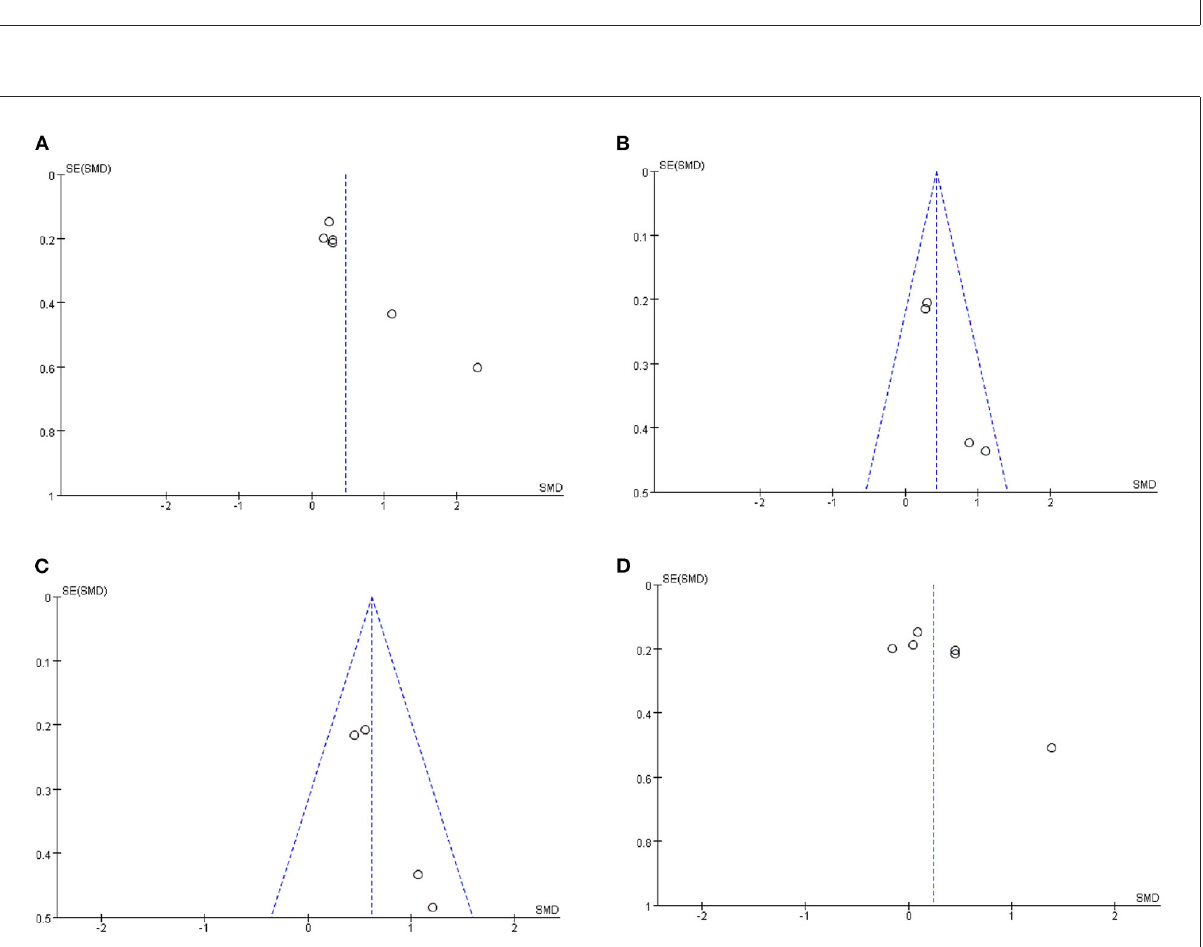
FIGURE8 Funnel plot of the included trials for the analyses at different language levels. (A) Overall expressive language development. (B) Overall vocabulary development. (C) Different words used in language sample. (D) Overall receptive language